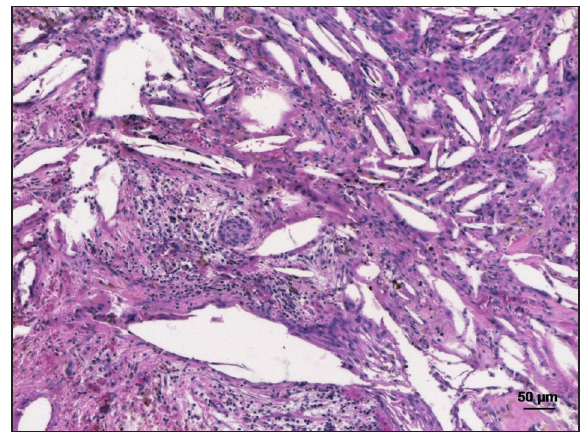
Figure 2 - Periapical cyst. Cholesterol crystals and foreign body-type reaction with giant cells present in the capsule (H&E; original magnification, 200 × ).